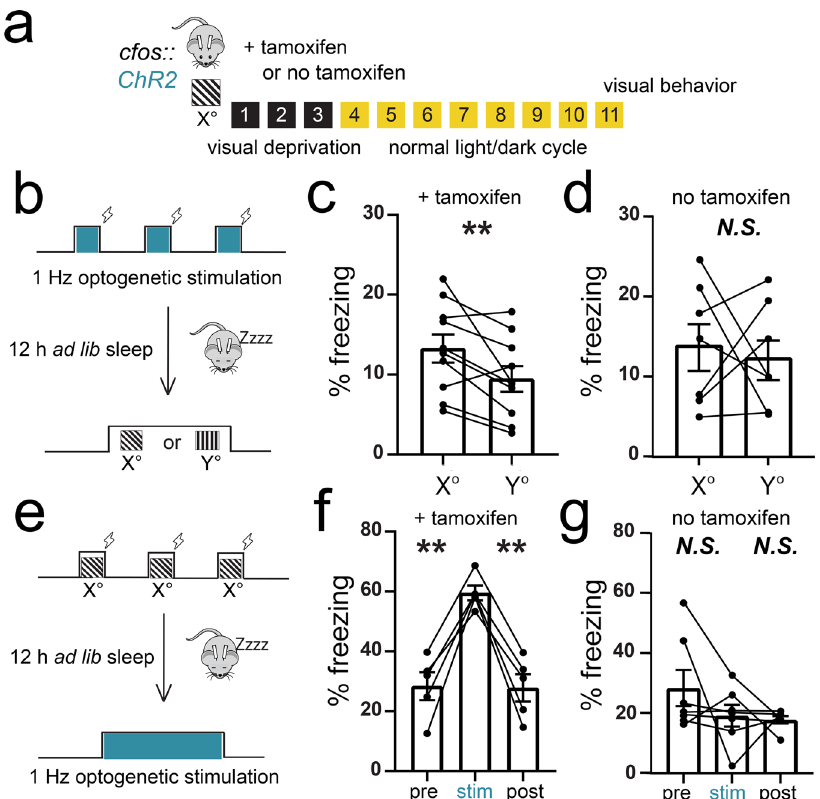
Fig. 3 Optogenetic stimulation of TRAPed V1 neurons mimics visual experience. a cfos::ChR2 mice with bilateral V1 fi ber optics had recombination induced to a speci fi c angle ( X °). As a negative control, a second cohort was treated identically, without tamoxifen administration to induce recombination (no tamoxifen). Eleven days later, visually driven fear behavior was assessed. b – d At ZT0, the mice received bilateral V1 optogenetic stimulation paired with foot shocks in lieu of the oriented grating visual stimuli used for cued conditioning in Fig. 1. At ZT12, the mice were presented with the same oriented grating used for TRAP ( X °) and an alternate orientation ( Y °). Optogenetically cued conditioning in tamoxifen-administered mice resulted in higher subsequent cued freezing responses to X ° relative to Y ° ( n = 10 mice; p = 0.008 [ t = 3.38, DF = 9], ratio paired t test). No tamoxifen controls showed no discrimination between X ° and Y ° (N.S., ratio paired t test). Values in c , d indicate mean ± SEM. e – g At ZT0, a second cohort of mice underwent visually cued fear conditioning to the same orientation as the TRAPed ensemble. At ZT12, the mice received optogenetic stimulation in place of the visual cue. Freezing behavior was higher during the 3-min optogenetic stimulation than before or after stimulation in tamoxifen-administered mice (3 and 1 min, respectively; n = 5 mice; pre vs. stim — p = 0.003 [ t = 7.30, DF = 4, stim vs. post — p = 0.003 [ t = 7.85, DF = 4], Holm – Sidak post hoc test, one-way RM ANOVA). No tamoxifen controls showed no fear response to V1 light delivery (N.S., one-way RM ANOVA). Values in f , g indicate mean ± rhythmic (1 Hz) light delivery. We fi rst generated tuning curves to assess orientation preference for each V1 neuron, measuring fi ring rate responses to a series of eight different oriented gratings.